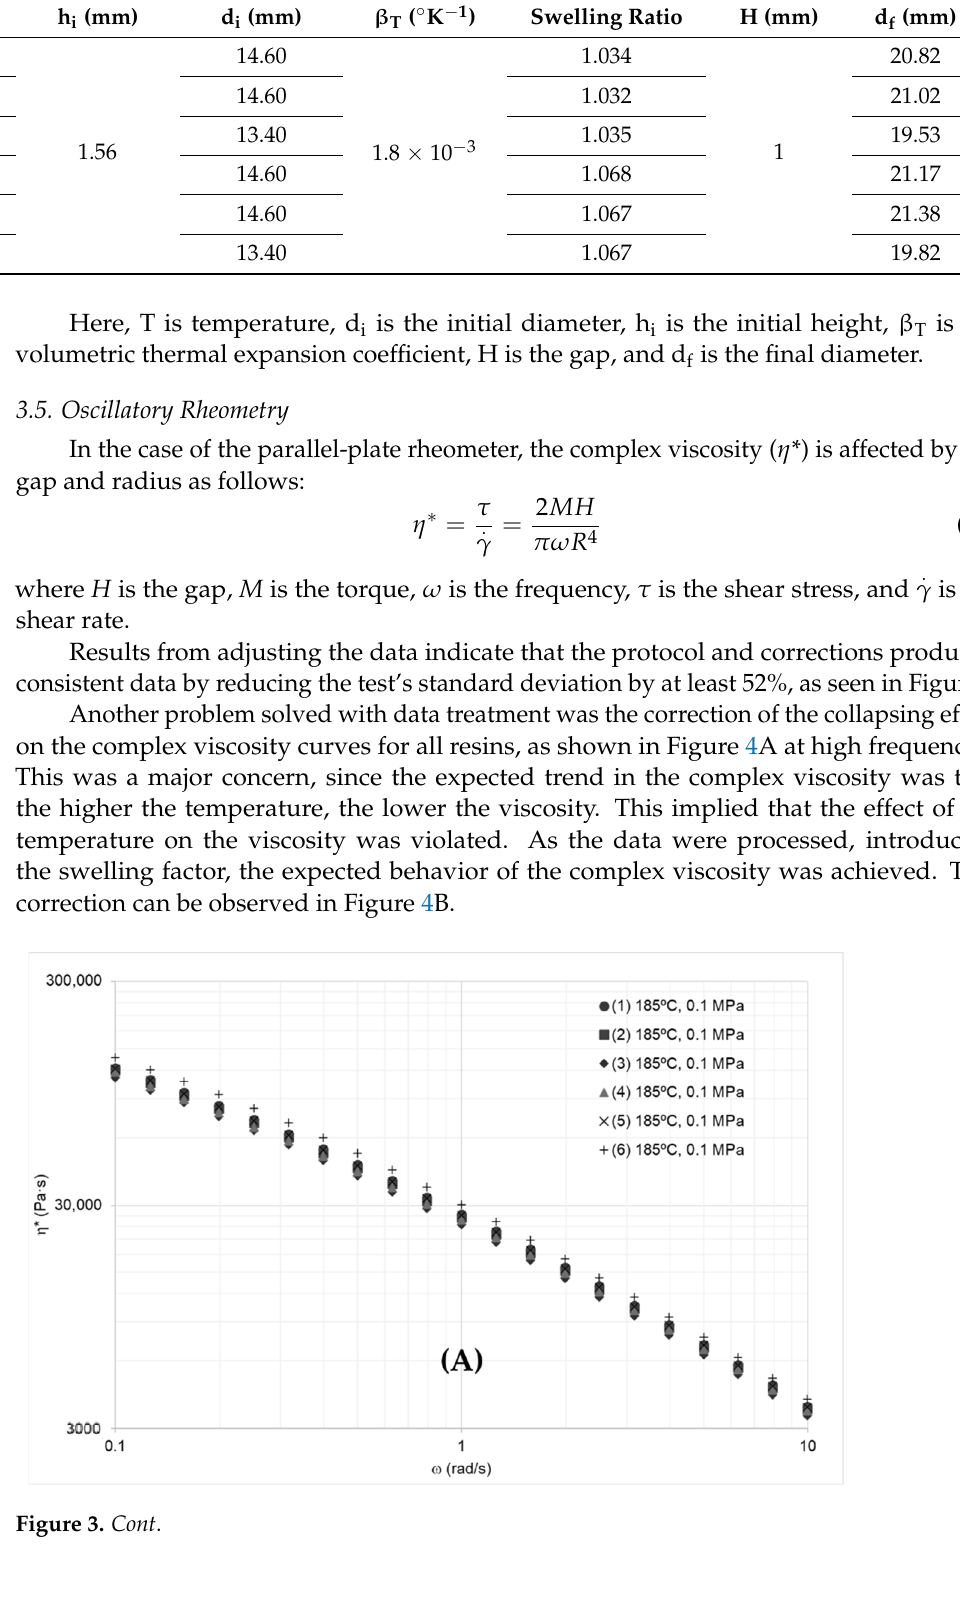
Table 12. Polymer discs dimensions after and during testing with SC-CO 2 .